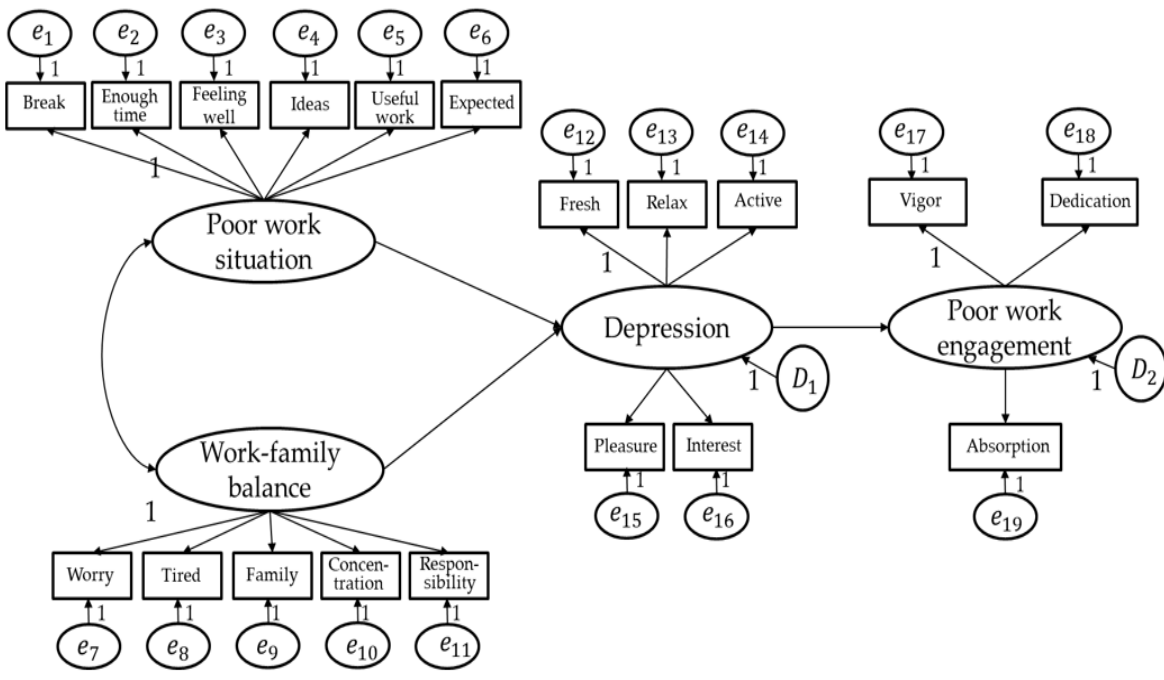
Figure 1. Conceptual structural equation model (SEM) of this study. Rectangle, measurement variable; ellipse, latent variable; Di, disturbance or residual; ei, measurement error.